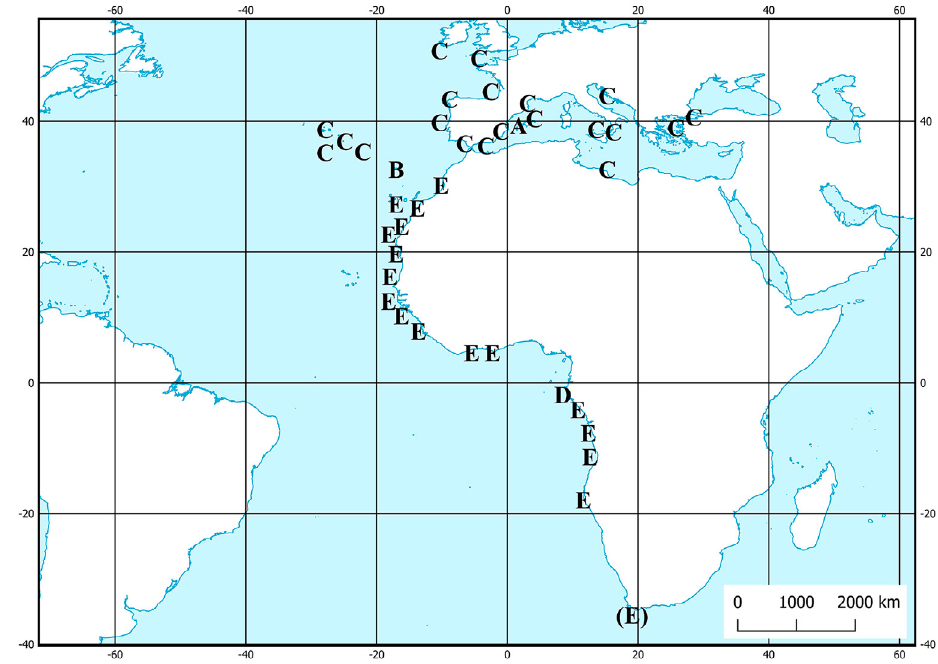
Fig. 5. – Geographical distribution of Arnoglossus imperialis and A. blachei in the eastern Atlantic and Mediterranean Sea. A. A. imperialis neotype. B. A. imperialis, neotype of Rhombus cristatus Lowe 1839. C. A. imperialis , other records. D. A. blachei lectotype. E. A. blachei , other